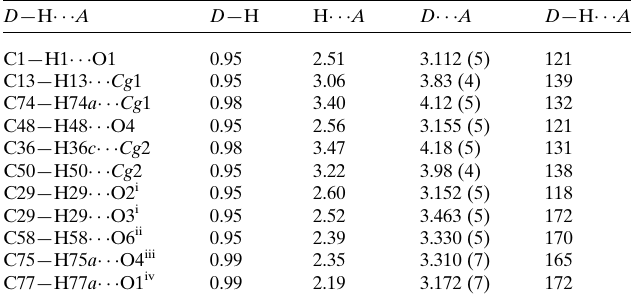
Table 2 Hydrogen-bond geometry (A˚ , (cid:3) ).